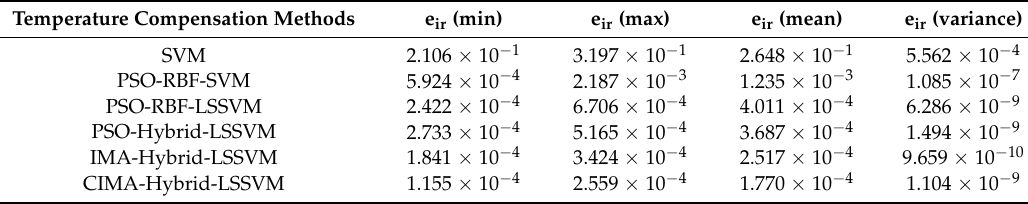
Table 4. Compensation results of testing set by random partition.